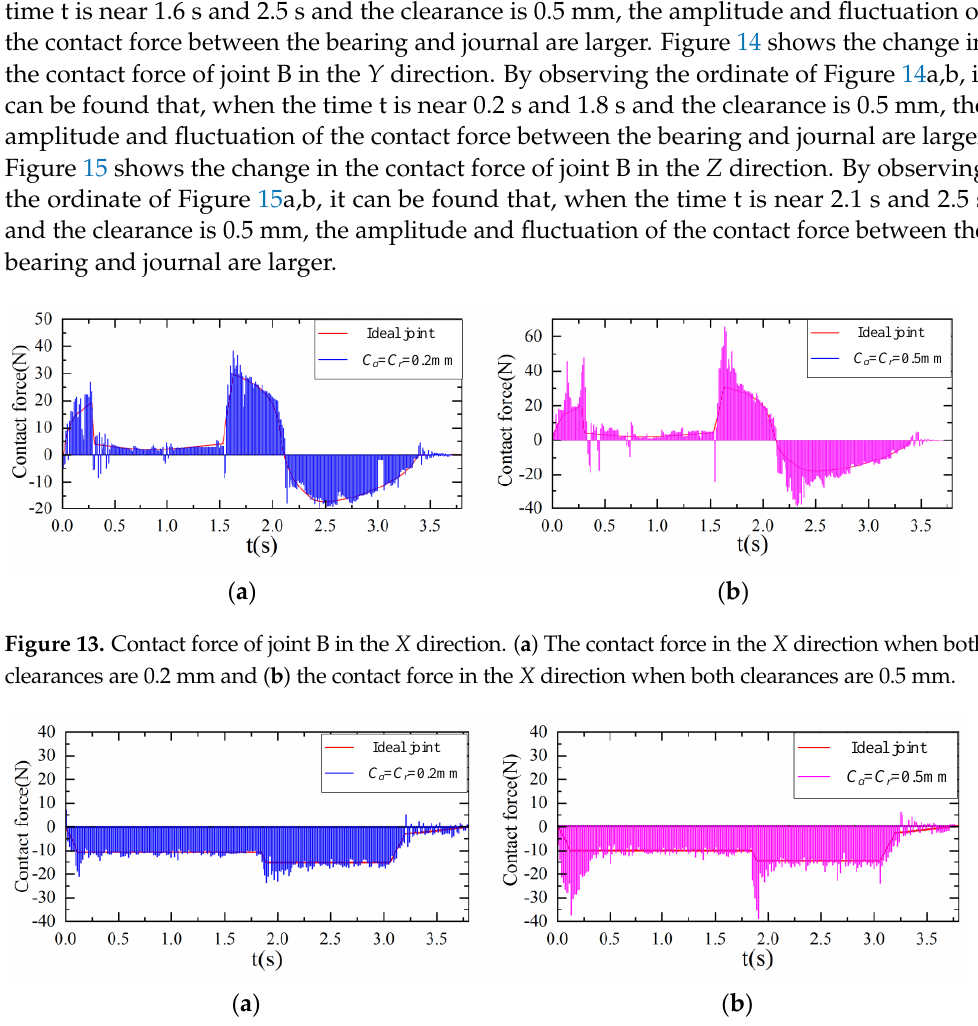
Figure 14. Contact force of joint B in the Y direction. ( a ) The contact force in the Y direction when both clearances are 0.2 mm and ( b ) the contact force in the Y direction when both clearances are 0.5 mm.